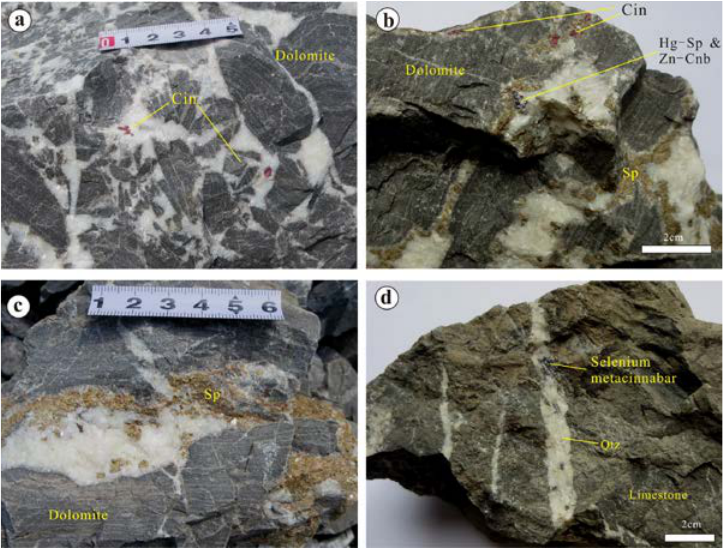
Figure 2. Photographs of typical mineralization style: ( a ) brecciated Hg ores, located in Hg zone of the Chashula deposit, showing dolomite breccia, dolomite cements, and disseminated cinnabar; ( b ) Hg–Zn ores located in Hg–Zn zone of the Chashula deposit, showing cinnabar, sphalerite, Hg-bearing sphalerite, and Zn-bearing cinnabar in irregular vein filling in dolomite; ( c ) Zn ores, located in the Zn zone of the Chashula deposit, showing sphalerite only in irregular vein-filling in dolomite; and ( d ) Hg–Ag ores of the No. I zone at the Dongping deposit, containing selenium metacinnabar, miargyrite, Hg-bearing freibergite in quartz (Qtz) vein filling in limestone.